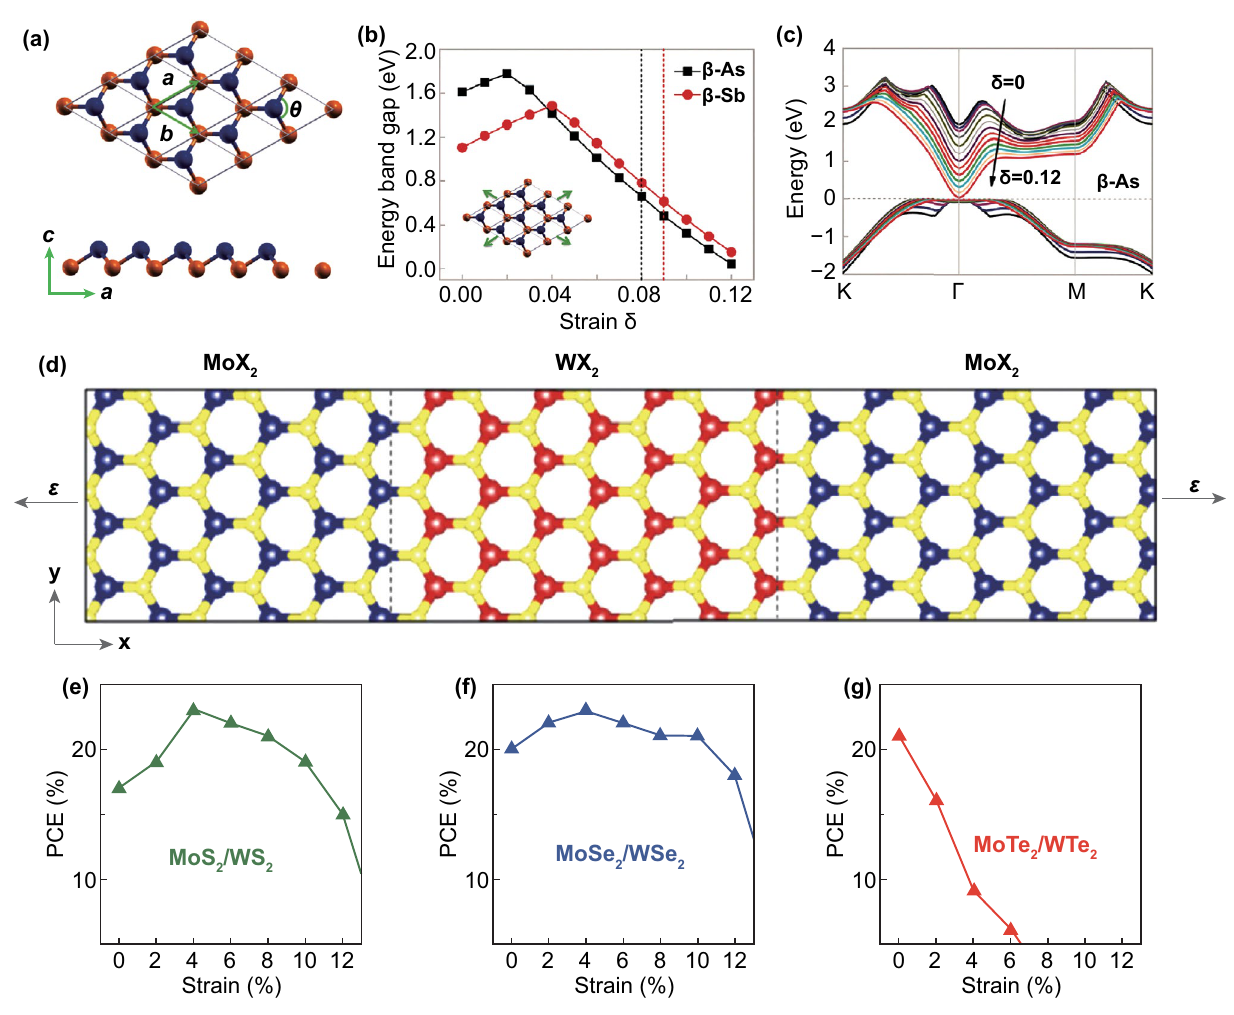
Fig. 5 Simulation studies of piezoresistive effect in 2D semiconductors and their heterostructures. a Crystal structures of monolayer β-As and β-Sb. b Band gap variation under biaxial tensile strain. The dot dashed line shows the position of the critical strain of indirect-direct gap transi- tion. c Positions of conduction and valence band edges under different strains. Reproduced with permission [114, 115]. Copyright 2018, Royal Society of Chemistry. d Geometric structures of the heterostructures containing a total of twenty MoX 2 and WX 2 units per supercell and applied uniaxial strain ε along the armchair direction. e–g Strain dependence of PCE in lateral heterostructures. Reproduced with permission [118]. Copyright 2017, IOP